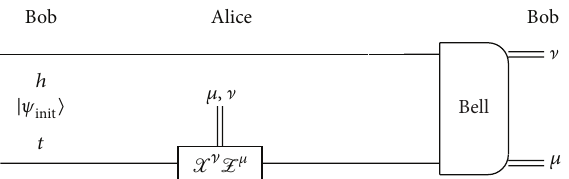
Figure 1: The schematic diagram of a message mode in the ping- pong protocol.